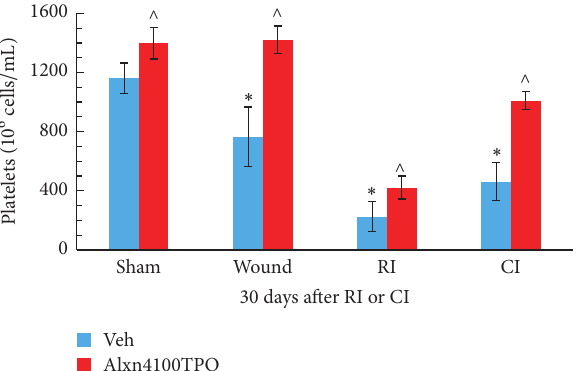
Figure 2: Alxn4100TPO mitigated platelet loss after RI and CI. Platelets were counted on day 30 in surviving sham, wounded, RI, and CI mice. 𝑁 = 6 per group. Data are presented as mean ± SEM. ∗ 𝑝 < 0.05 versus Vehicle Sham; ∧ 𝑝 < 0.05 versus respective vehicle group. RI: 9.5 Gy; CI: 9.5 Gy and skin wound.